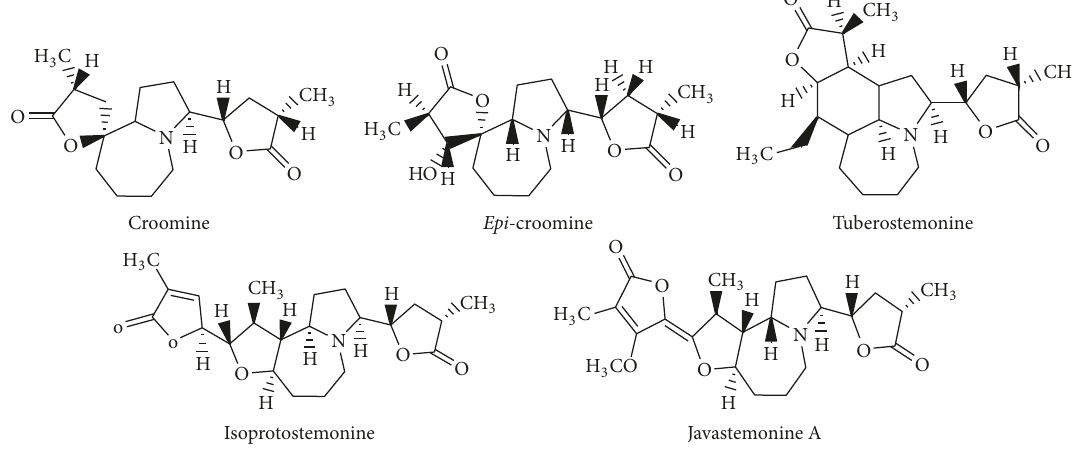
Figure 1: Structure of alkaloids from the roots of Stemona